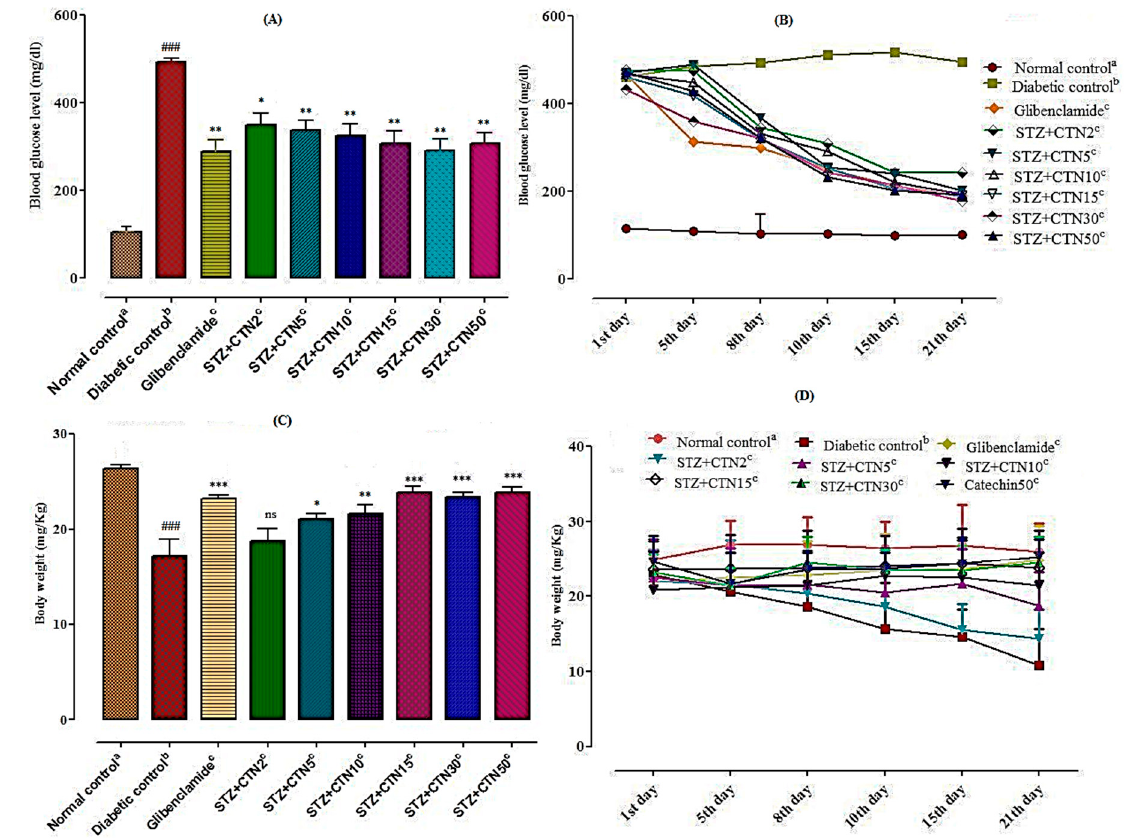
Figure 2. Effect of various treatments on blood glucose level and body weight of STZ-induced diabetic rats ( A , B ). Blood glucose level in different treatment groups ( C , D ). Effect of various treatment groups on body weight in STZ-induced diabetic rats. ( A ) is showing the blood glucose levels at the end of treatment period while ( B ) shows blood glucose levels at different week. ( C ) is showing the body weight (mg/kg) at the end of treatment period while ( D ) shows body weight (mg/kg) at different week. [The values are expressed as mean ± SEM. ns = non-significant. Each value corresponds to a mean of eight animals. ### p ˂ 0.001; comparison of a (normal control) vs. b (diabetic control) using Student’s t-test, * p ˂ 0.05, ** p ˂ 0.01, *** p < 0.001; comparison of b (diabetic control) vs. c (glibenclamide and CTN treated groups) using one way ANOVA followed by Dunnett’s post hoc multiple comparison test].